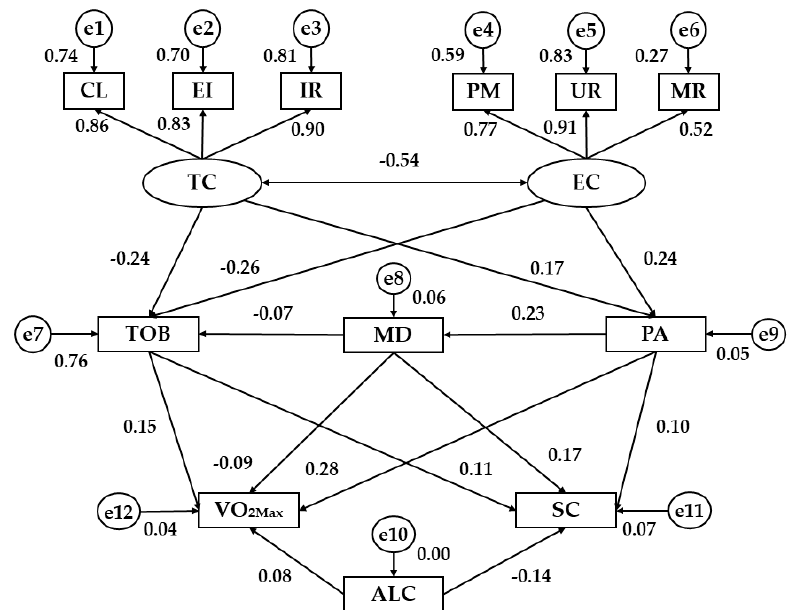
Figure 3. Structural equation model for women. Note: TC, Task Climate; EC, Ego Climate;